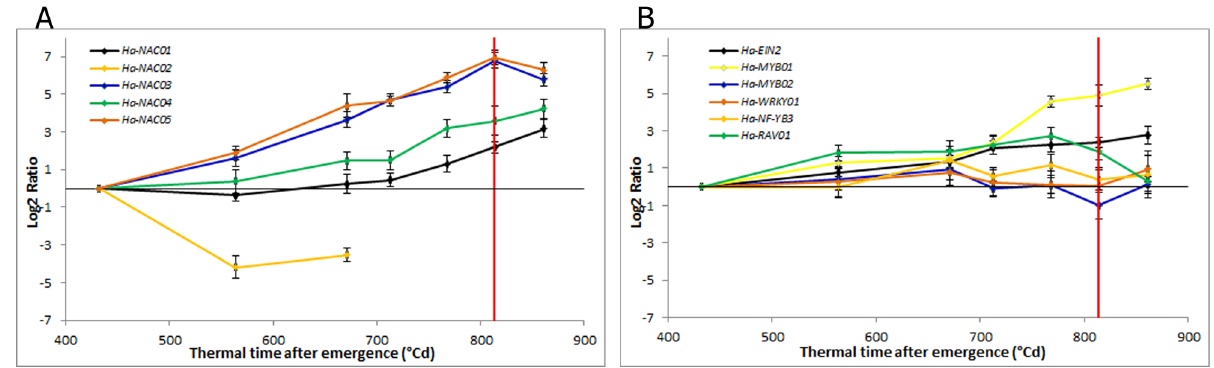
Figure 3. Expression profiles of transcription factors. (A) NAC TFs relative transcript level at each sampled point in relation to the level at the first sampling point determined by qPCR in leaf 10 ( Ha-EF1 a as RG). (B) AP2/EREBP, MYB, WRKY, NF-Y and RAV TFs relative transcript level at each sampled point in relation to the level at the first sampling point determined by qPCR in leaf 10 ( Ha - EF1 a as RG). The red line indicates anthesis time. Error bars correspond to standard errors.